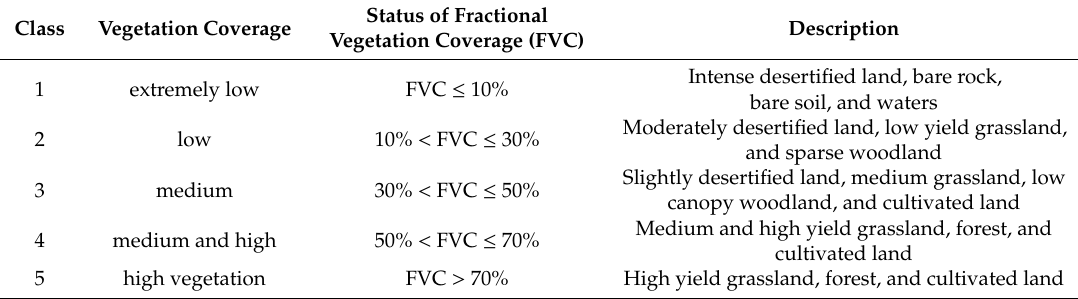
Table 1. Vegetation Coverage Classification Standards